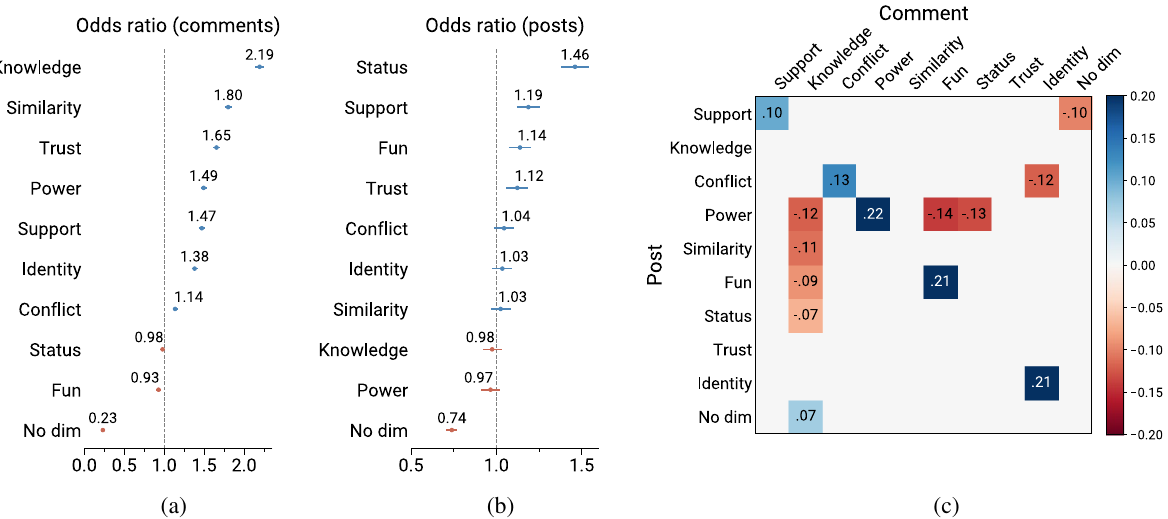
Figure 1. Odd ratios of containing a dimension ( a ) in comments that were successful in changing the poster’s opinion versus those that were not, and ( b ) in posts expressing opinions that were changed by other community members versus posts that did not experience any opinion change. Error bars represent 95% confidence intervals. On the right ( c ), we report only the statistically significant odds ratios ( P < 0.01) for interactions between dimensions in comments and posts. Cells represent the variation of the probability of achieving a (cid:31) given a combination of dimensions.